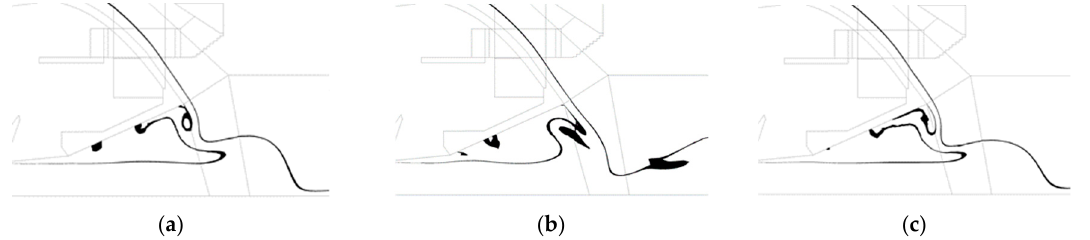
Figure 14. Swing of the surface jet at the impingement with the outlet jet, three subsequent instantaneous jet profiles (solid lines correspond to volume of fluid (VOF) = 0.5): ( a ) t = 17.9 s; ( b ) t = 18.5 s; ( c ) t = 19.1 s.